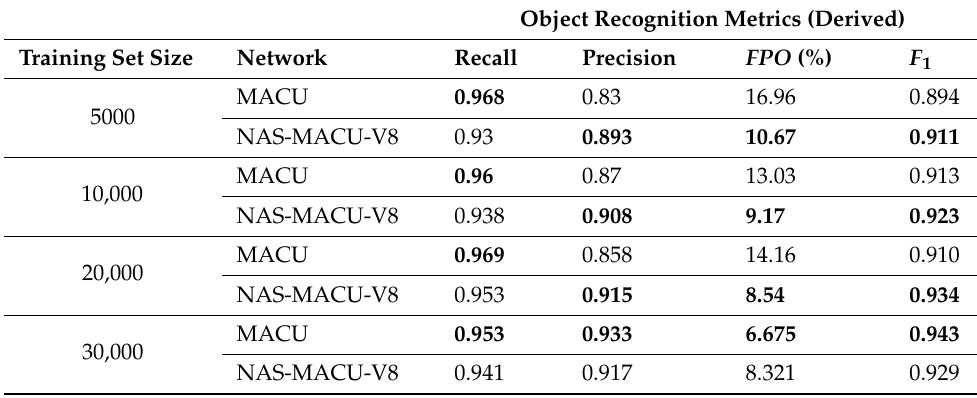
Table 6. NAS-MACU-V8 vs. MACU in the variable information environments.